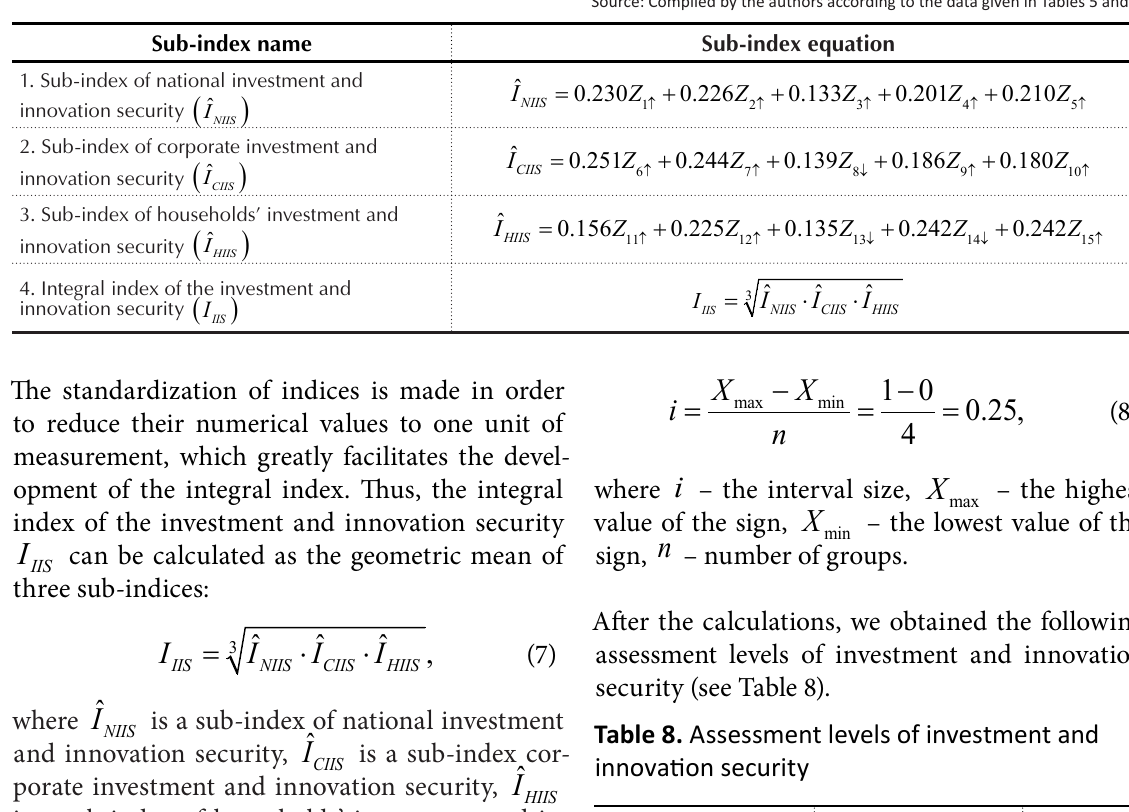
Table 7. Equation of sub-indices of the investment and innovation security Source: Compiled by the authors according to the data given in Tables 5 and